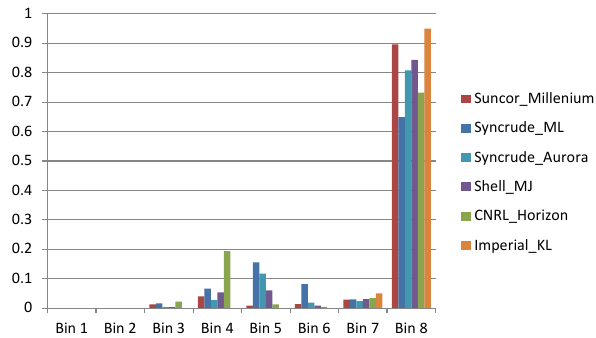
Figure 10. PM 2 . 5 size distribution derived from the aircraft obser- vations for the six AOSR mining